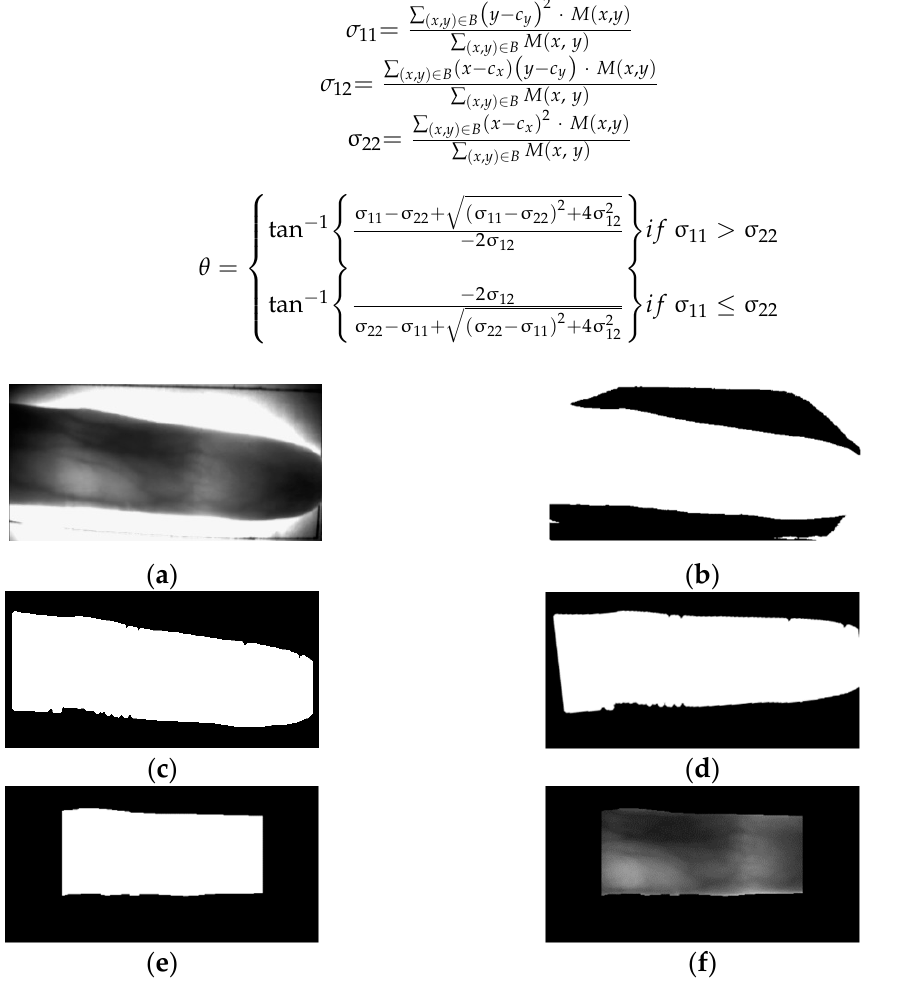
Figure 2. Original finger-vein image preprocessing: ( a ) original image; ( b ) binarized image; ( c ) back- ground removed image; ( d ) in-plane rotation compensation; ( e ) removal of left and right areas; and ( f ) detected finger-vein ROI image.